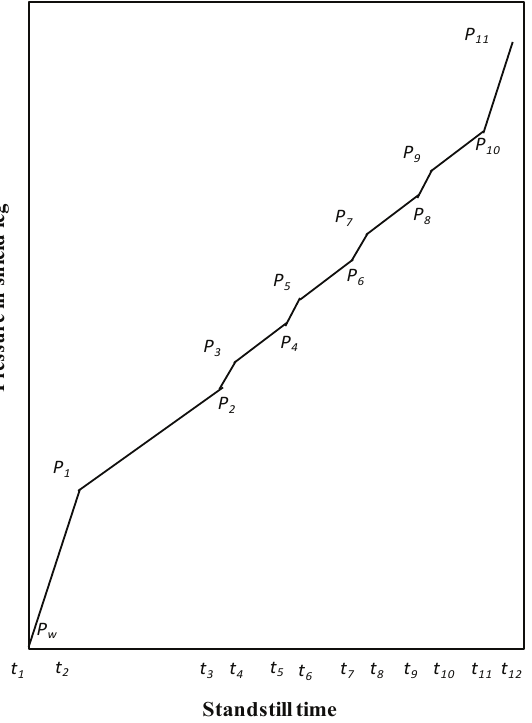
of the plough support r